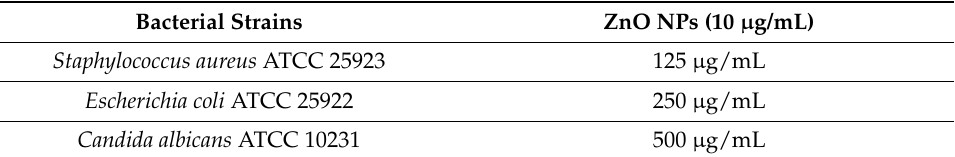
Table 3. MIC values for the tested ZnO